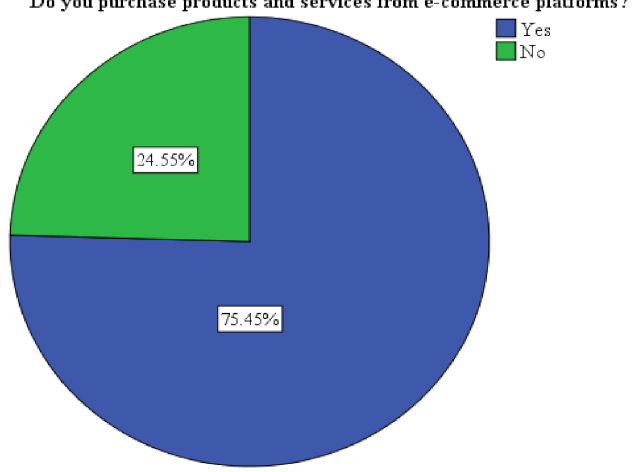
Figure 2. Participants purchase products from e-commerce